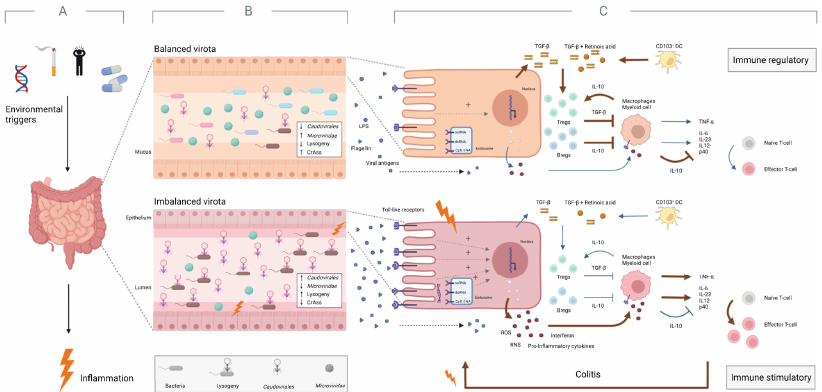
Figure 3. IBD patients possess an imbalanced intestinal virota and a dysregulated immune system under inflammatory conditions. ( A ) Environmental factors (e.g., smoking, stress, and Western diet) are believed to trigger intestinal inflammation in individuals predisposed to IBD. ( B ) This inflammatory condition is characterized by various viral imbalances compared to a healthy, non-inflamed gut. These imbalances include a high relative abundance of Caudovirales and a low relative abundance of Microviridae . In addition, the imbalances indicate a depletion of CrAss-like phages and possibly expansion of the lysogenic potential of the virome. ( C ) The altered intestinal virota is also associated with a dysregulated immune system. Here, breakdown of the mucus layer allows larger amounts of microbial antigens (e.g., viral antigens, flagellin) to stimulate Toll-like receptors in the intestinal mucosa, leading to the upregulation of proinflammatory signaling pathways and promotion of colitis. Red and blue arrows indicate the upregulated and downregulated pathways, respectively. Created with BioRender.com.